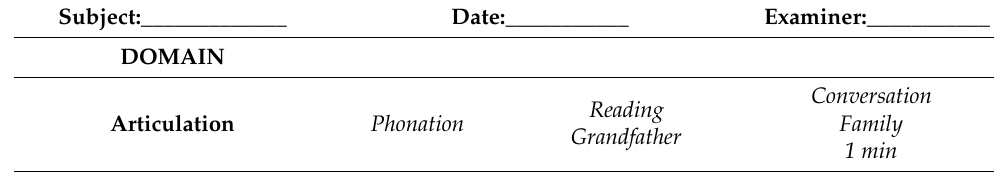
Table A4. Study: Efficacy of Speech Treatment in Parkinson’s